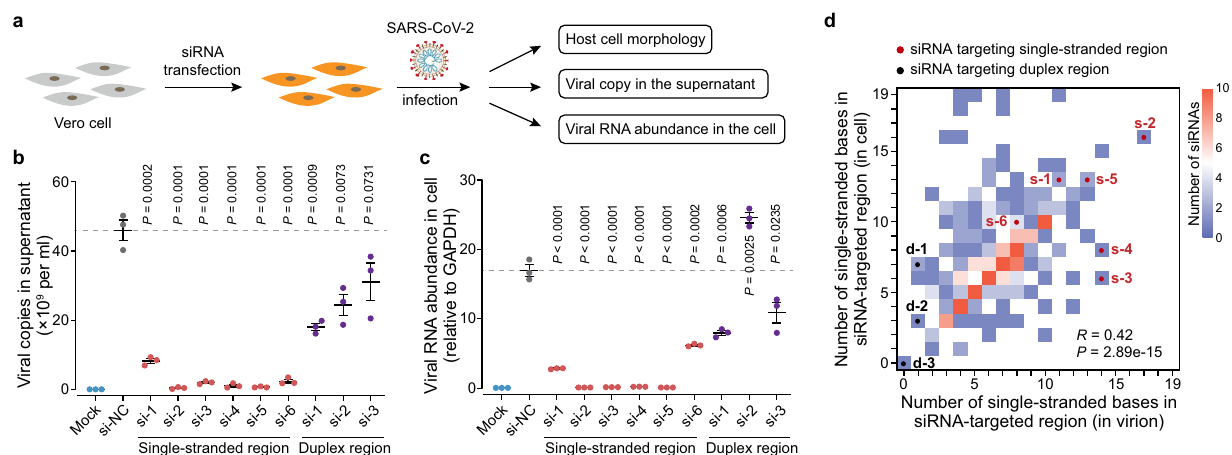
Fig. 7 Structure-guided design of potent siRNAs as a cleavage agent to restrict SARS-CoV-2 infection. a Diagram of strategy against SARS-CoV-2 infection in Vero cells. b The SARS-CoV-2 copies in the supernatant were reduced to background level upon transfection with siRNAs targeting single- stranded regions (si-1 to si-6). Mock, uninfected cells; si-NC, non-targeting siRNA (control). c qPCR showing the abundance of viral RNA in infected Vero cells. Data in ( b ) and ( c ) are mean ± s.e.m.; n = 3 biological replicates, two-tailed, unpaired Student ’ s t -test. Source data are provided as a Source Data fi le. d Number of single-stranded bases within the siRNA target regions identi fi ed in cells and virions. The color intensity denotes the number of siRNAs. The six siRNAs targeting single-stranded regions and three siRNAs targeting duplex regions are labeled as s-1 to s-6 and d-1 to d-3, respectively. R , Pearson correlation coef fi cient. P -value was determined by two-sided correlation